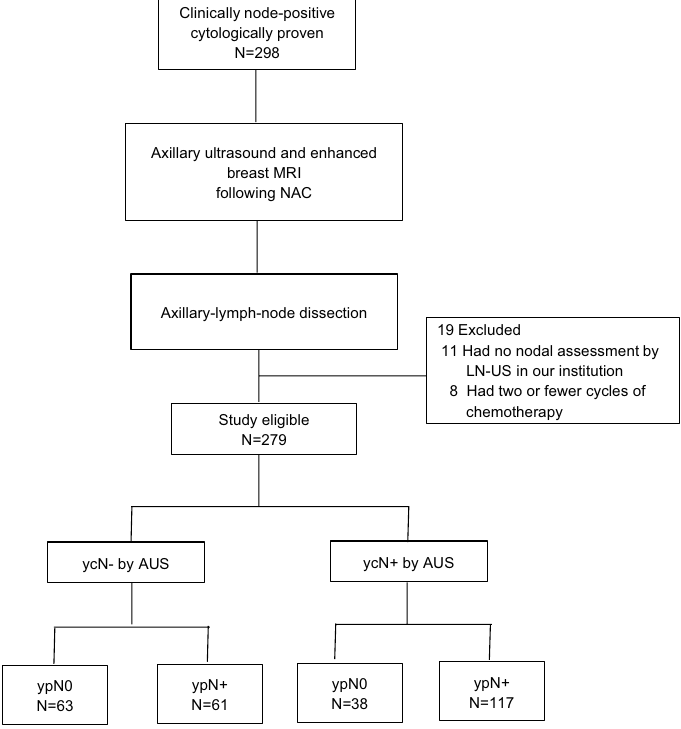
Figure 2. Flow diagram of the study. AUS axillary ultrasound, NAC neoadjuvant